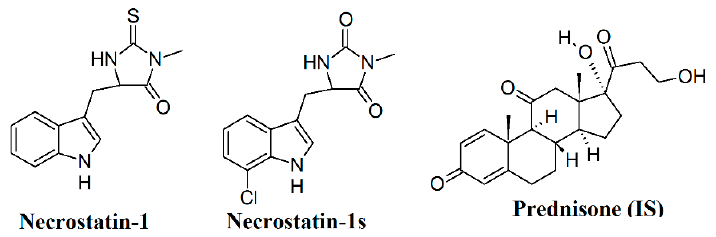
Figure 1. Chemical structures of necrostatin-1, necrostatin-1s, and prednisone (internal standard, IS).